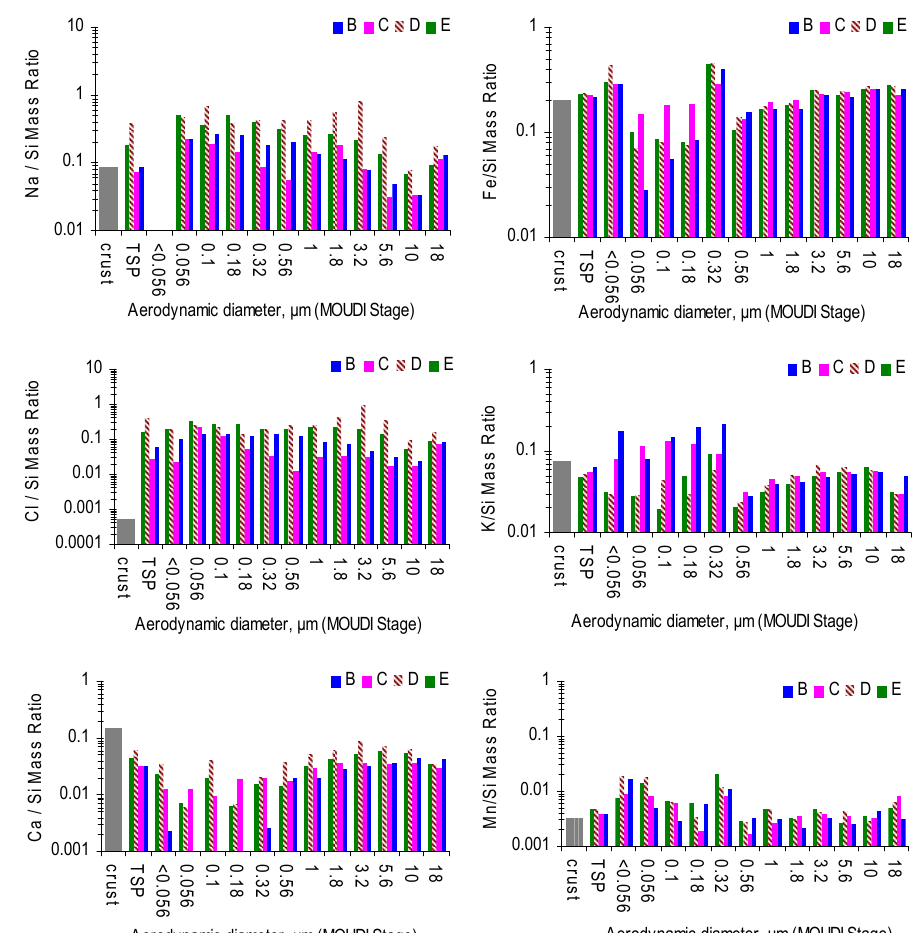
Fig. 8. Size-resolved mass ratios of some elements to Si for all samples.